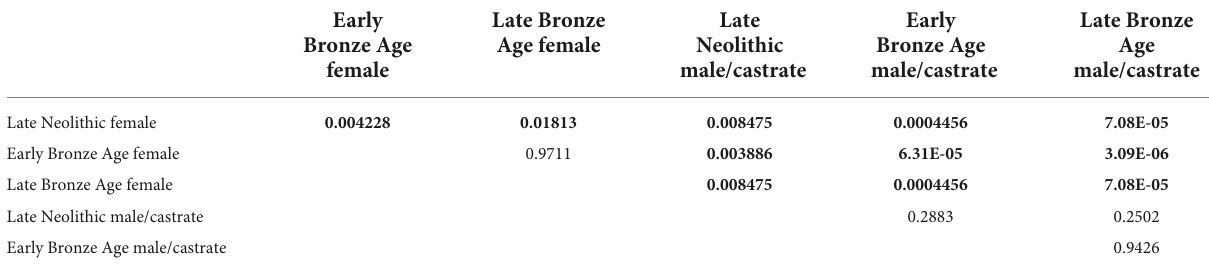
TABLE 4 Mann–Whitney U test pairwise comparisons of female and male/castrate cattle metacarpal Bd from the Late Neolithic to Late Bronze Age